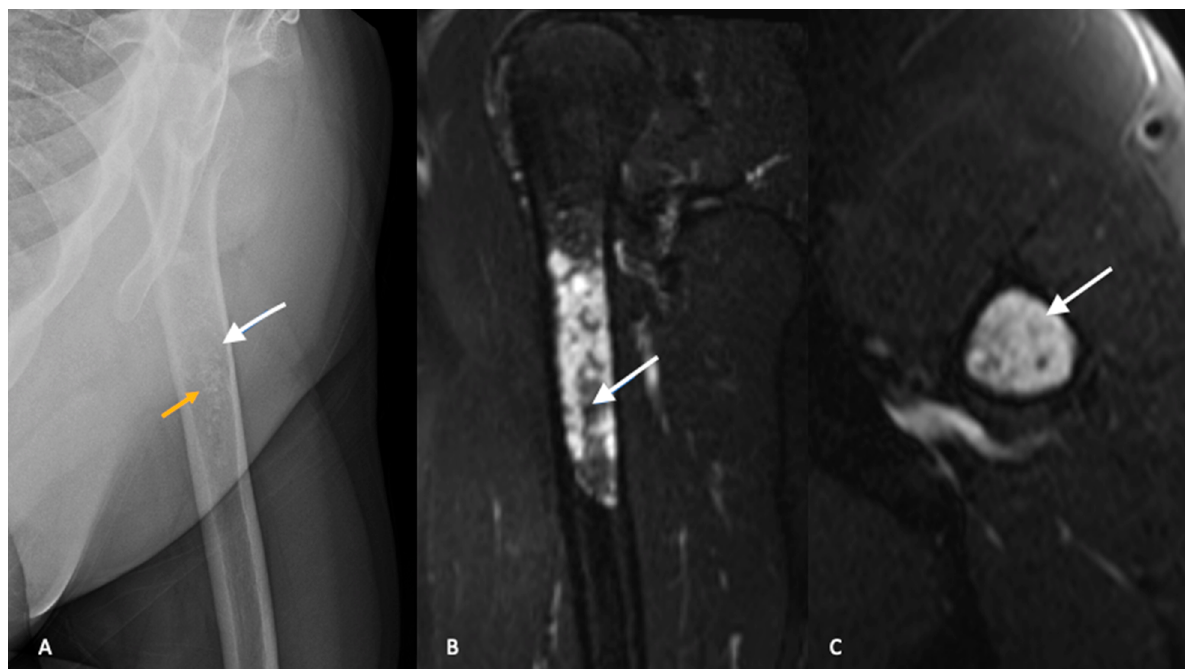
Figure 1. Radiograph ( A ) of the left proximal humerus demonstrates subtle lucency with internal stippled calcified foci (yellow arrow), in keeping with chondroid matrix. Subtle endosteal scalloping is present (white arrows) without cortical breakthrough or periosteal reaction. Sagittal ( B ) and axial ( C ) T2-weighted images with fat saturation of the same patient demonstrating a lobulated T2 hyperintense mass. A few stippled areas of low signal intensity represent chondroid matrix (white arrow). The lesion measures greater than 5 cm in length. Axial images demonstrate endosteal scalloping at the anterolateral border. No periostitis or cortical breakthrough. Imaging features are in keeping with an atypical cartilaginous tumor, which was con fi rmed on pathology after surgical cure tt age.